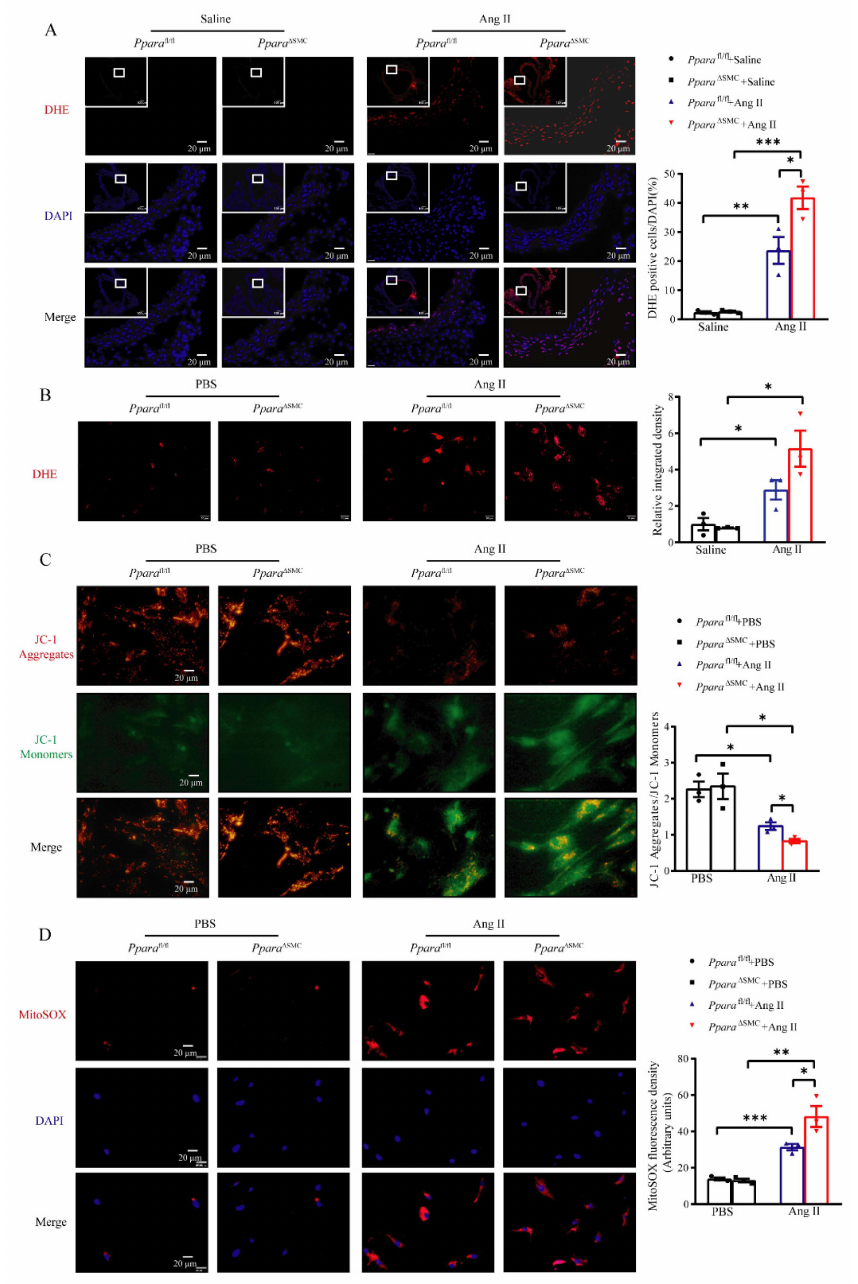
Figure 4. PPAR α deficiency in VSMCs aggravated Ang II − induced vascular oxidative stress ( A ) Representative images and analysis of dihydroethidium (DHE) staining for aortic cross sections from Ppara ∆ SMC and Ppara fl/fl mice. Scale bar = 20 µ m. ( B ) Representative images and analysis of DHE staining for VSMCs from Ppara ∆ SMC and Ppara fl/fl mice. Scale bar = 20 µ m. ( C ) Representative images and analysis of JC-1 aggregates and JC-1 monomers in VSMCs from Ppara ∆ SMC and Ppara fl/fl mice were treated with Ang II (1 µ mol/L) for 24 h. The orange fluorescence represents the superposition of green fluorescence (JC-1 monomer) and red fluorescence (JC-1 aggregate). Scale bar = 20 µ m. ( D ) Representative images and analysis of MitoSOX staining for VSMCs from Ppara ∆ SMC and Ppara fl/fl mice were treated with Ang II (1 µ mol/L) for 24 h (scale bar = 20 µ m, n = 3, two-way ANOVA). Data are means ± SEM. * p < 0.05, ** p < 0.01, *** p < 0.01 between